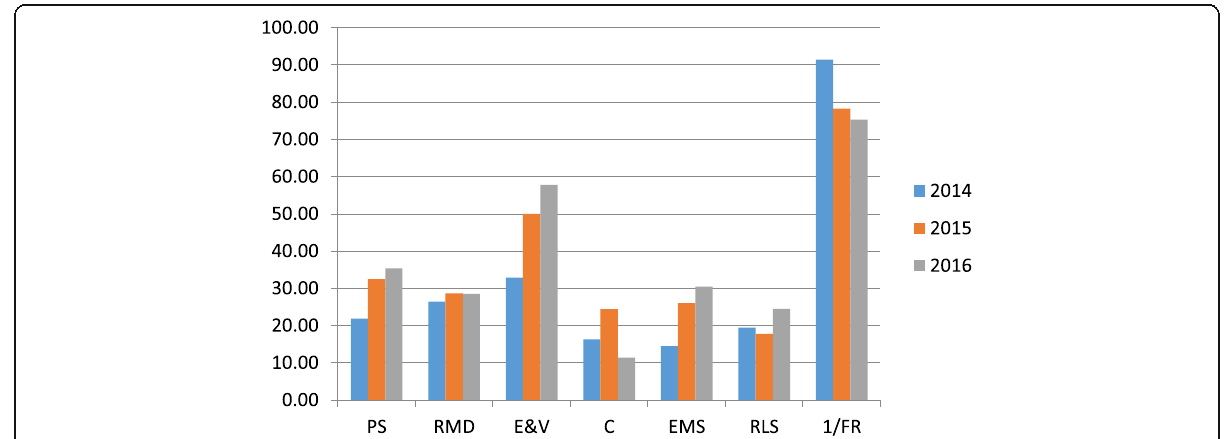
Fig. 10 The average deviation of input and output variables from the ideal situation for the years